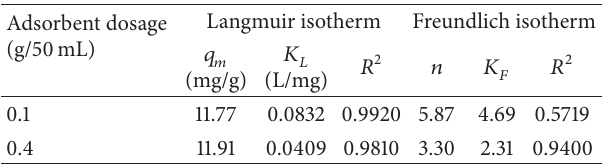
Table 3: Langmuir and Freundlich coefficients and regression cor- relation coefficients for adsorption of RY dyes onto SSCAC at 293